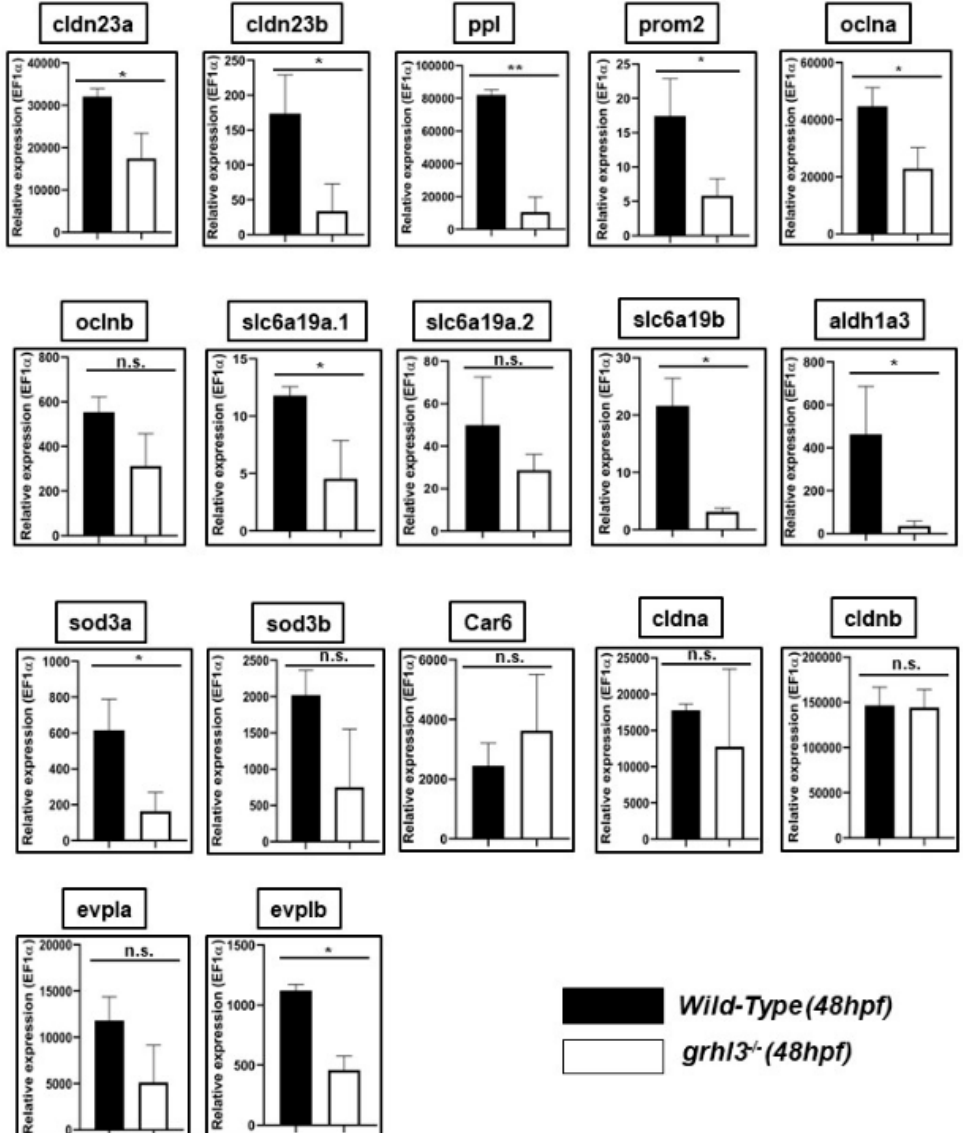
Figure 2. Q-RT-PCR analysis of zebrafish orthologue expression in 48 hours post-fertilisation (hpf) WT and grhl3 -/- embryos. Gene expression was normalised to expression of housekeeping gene EF1a. Of the 18 fish orthologues selected, 10 showed differential expression in WT (black bars) vs grhl3 -/- (white bars) embryos. * p < 0.05, ** p < 0.01, n.s., non-significant.